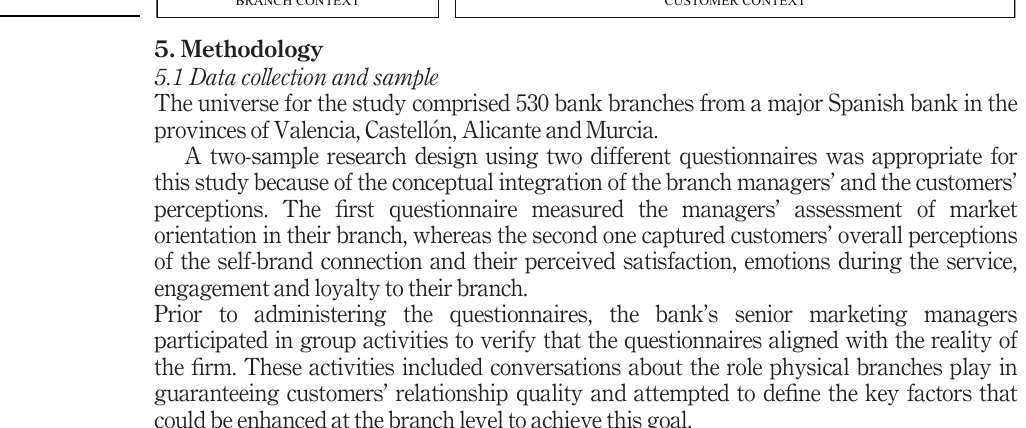
Figure 1. Model of